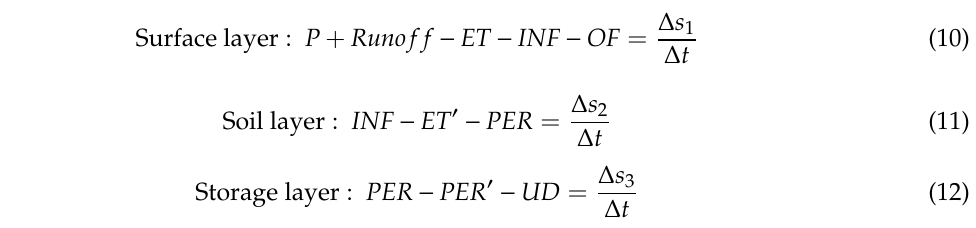
Figure 5. Schematic pattern of mass balance for infiltration-based BMPs in three separate layers. The mass balance equations for each layer are given in Equations (10) to